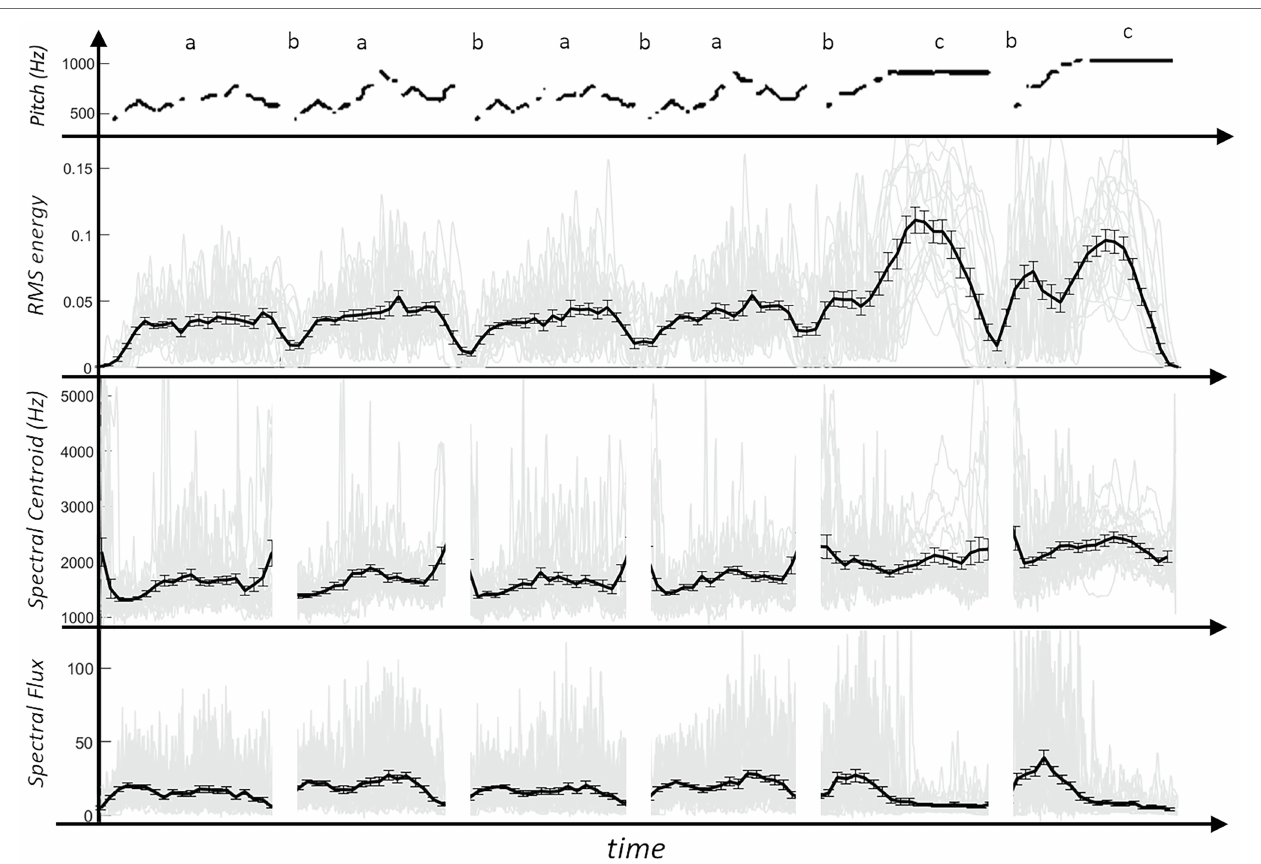
FIGURE 3 | Graphs of the four acoustic parameters (top row: schematic of the pitch; gray lines: individual values of the players; thick black line: mean value across all players; error bar: standard error of the